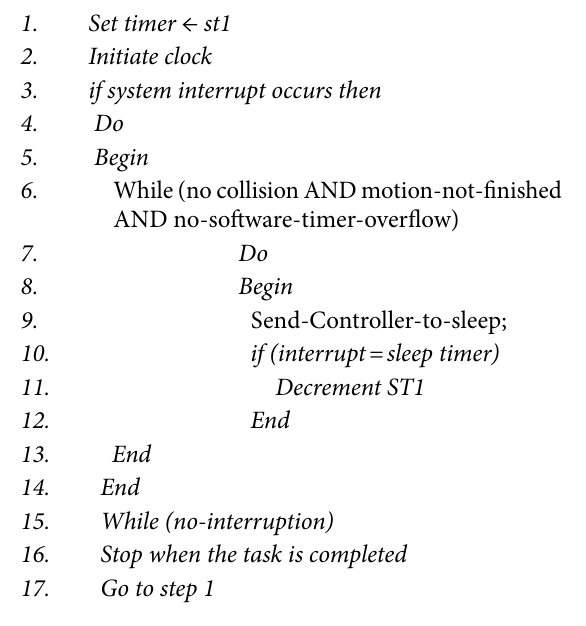
Table 1: Power consumption in robot